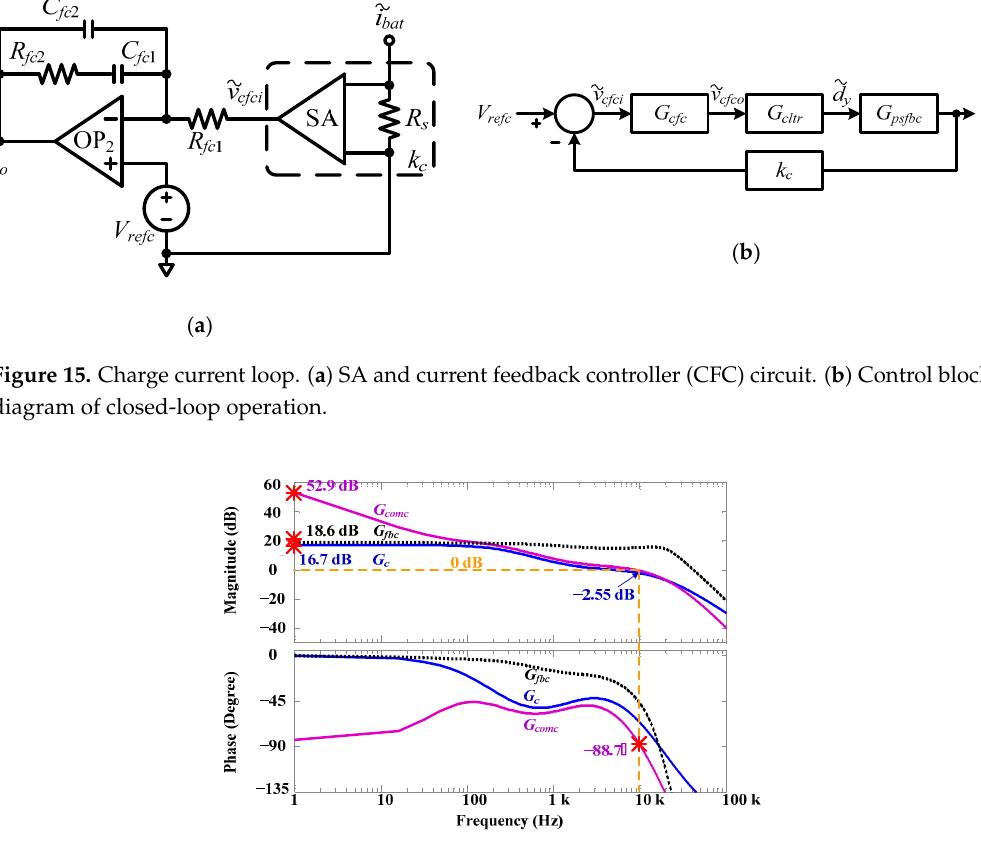
Figure 17. Frequency point design of charge current loop. ( a ) Normal PI design. ( b ) Using the zero break frequency shift (ZBFS) method.